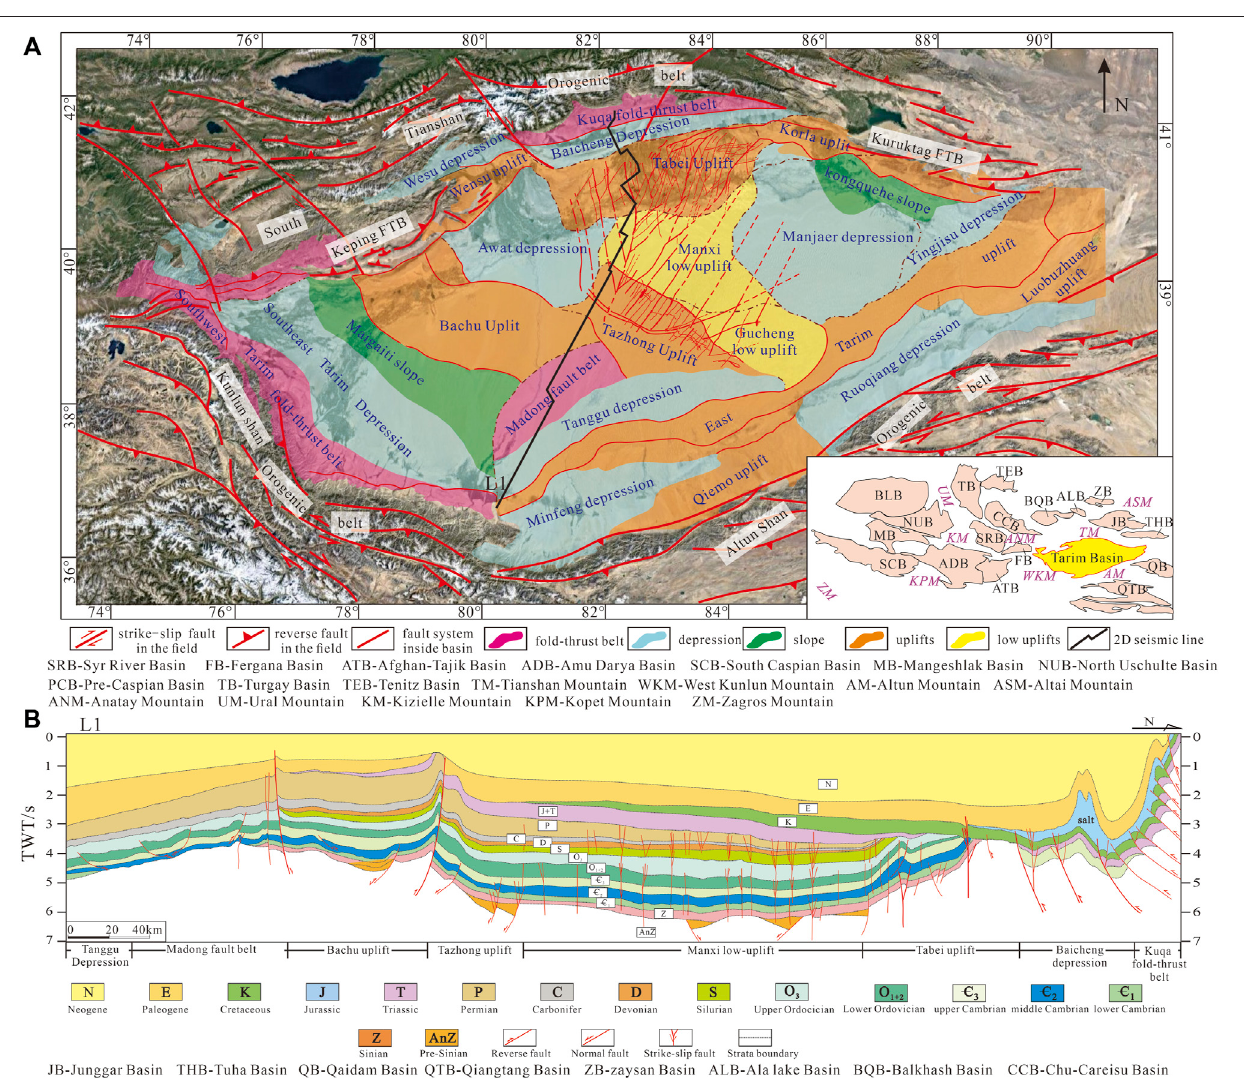
FIGURE 1 | (A) Geological map of the Tarim Basin (modi fi ed from Laborde et al., 2019). It is surrounded by the Tian Shan, Kunlun Shan, and Altun Shan Orogenic belts. Thrusts and strike-slip fault systems were found in the mountain belts. (B) Regional pro fi le of the Tarim Basin (L1 line in Figure 1 ).